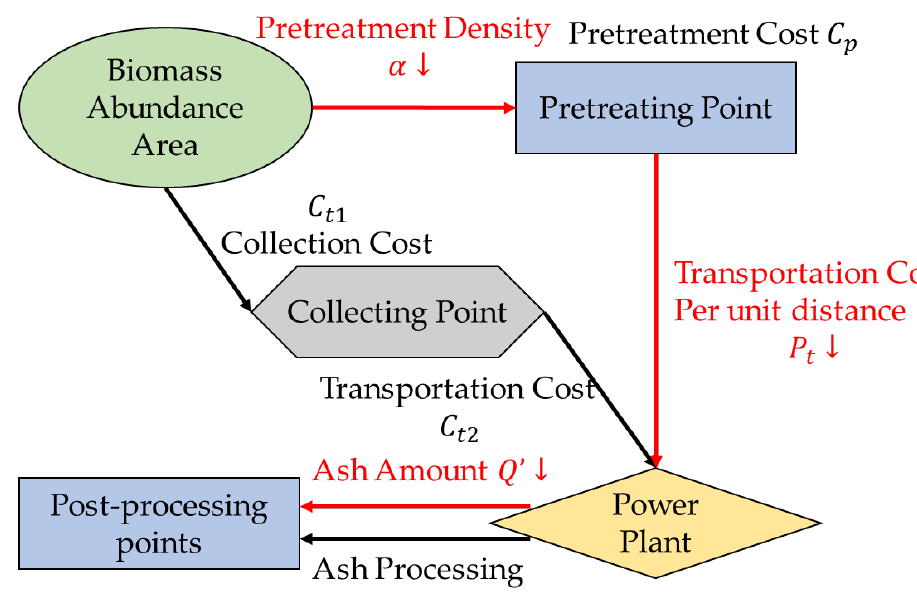
Figure 8. Comparison of direct combustion and pretreatment (taking Myanmar as an example).